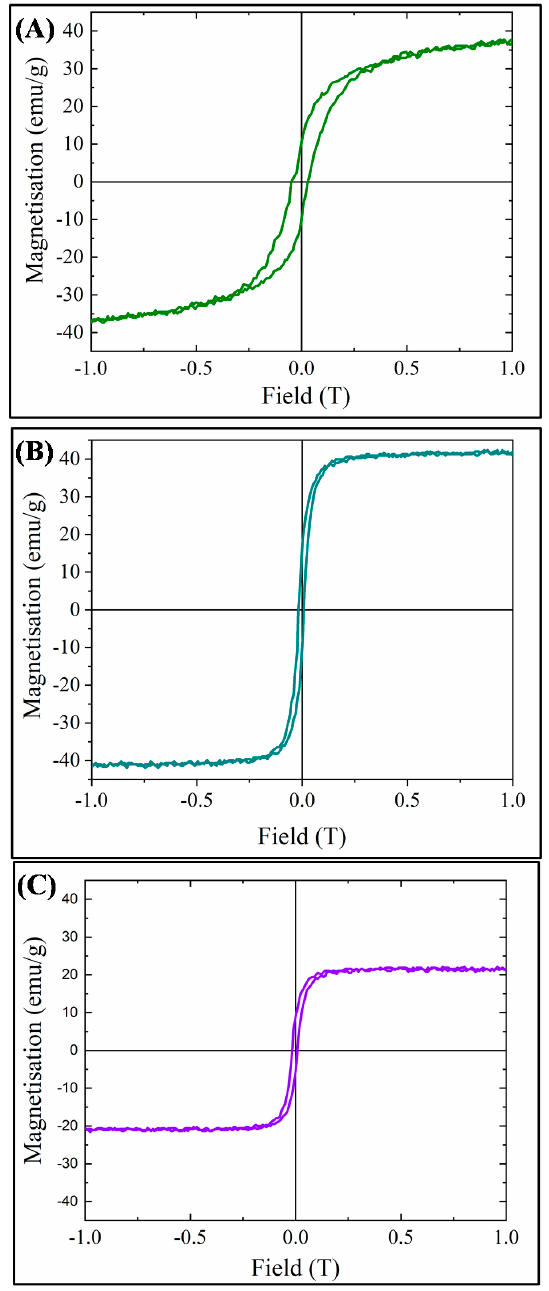
Figure 7. VSM hysteresis loops for: ( A ) CF MMOF; ( B ) ZF(acac) MMOF; and ( C ) ZF(Cl) MMOF. N 2 absorption isotherms for all three MMOFs as well as UiO-66 are presented in Figure 8. SSAs are calculated via this isotherms at 1132, 332, 244 and 311 m 2 /g for UiO-66, CF MMOF, ZF(acac) MMOF and ZF(Cl) MMOF, respectively. SSA reduction is estimated at 71%, 78% and 71% for CF, ZF(acac) and ZF(Cl) MMOFs correspondingly when com- pared with the initial MOF (UiO-66). Additionally, the integration of the two matrices (MNPs and MOF) is indicated and ensures high stability. However, the resulted SSA magnitudes can be considered moderate and higher than about 25% of the reported MMOFs that span in the range of 17 to 1248 emu/g [19–22]. Table 1 sums the physico- chemical traits for all three MMOFs.